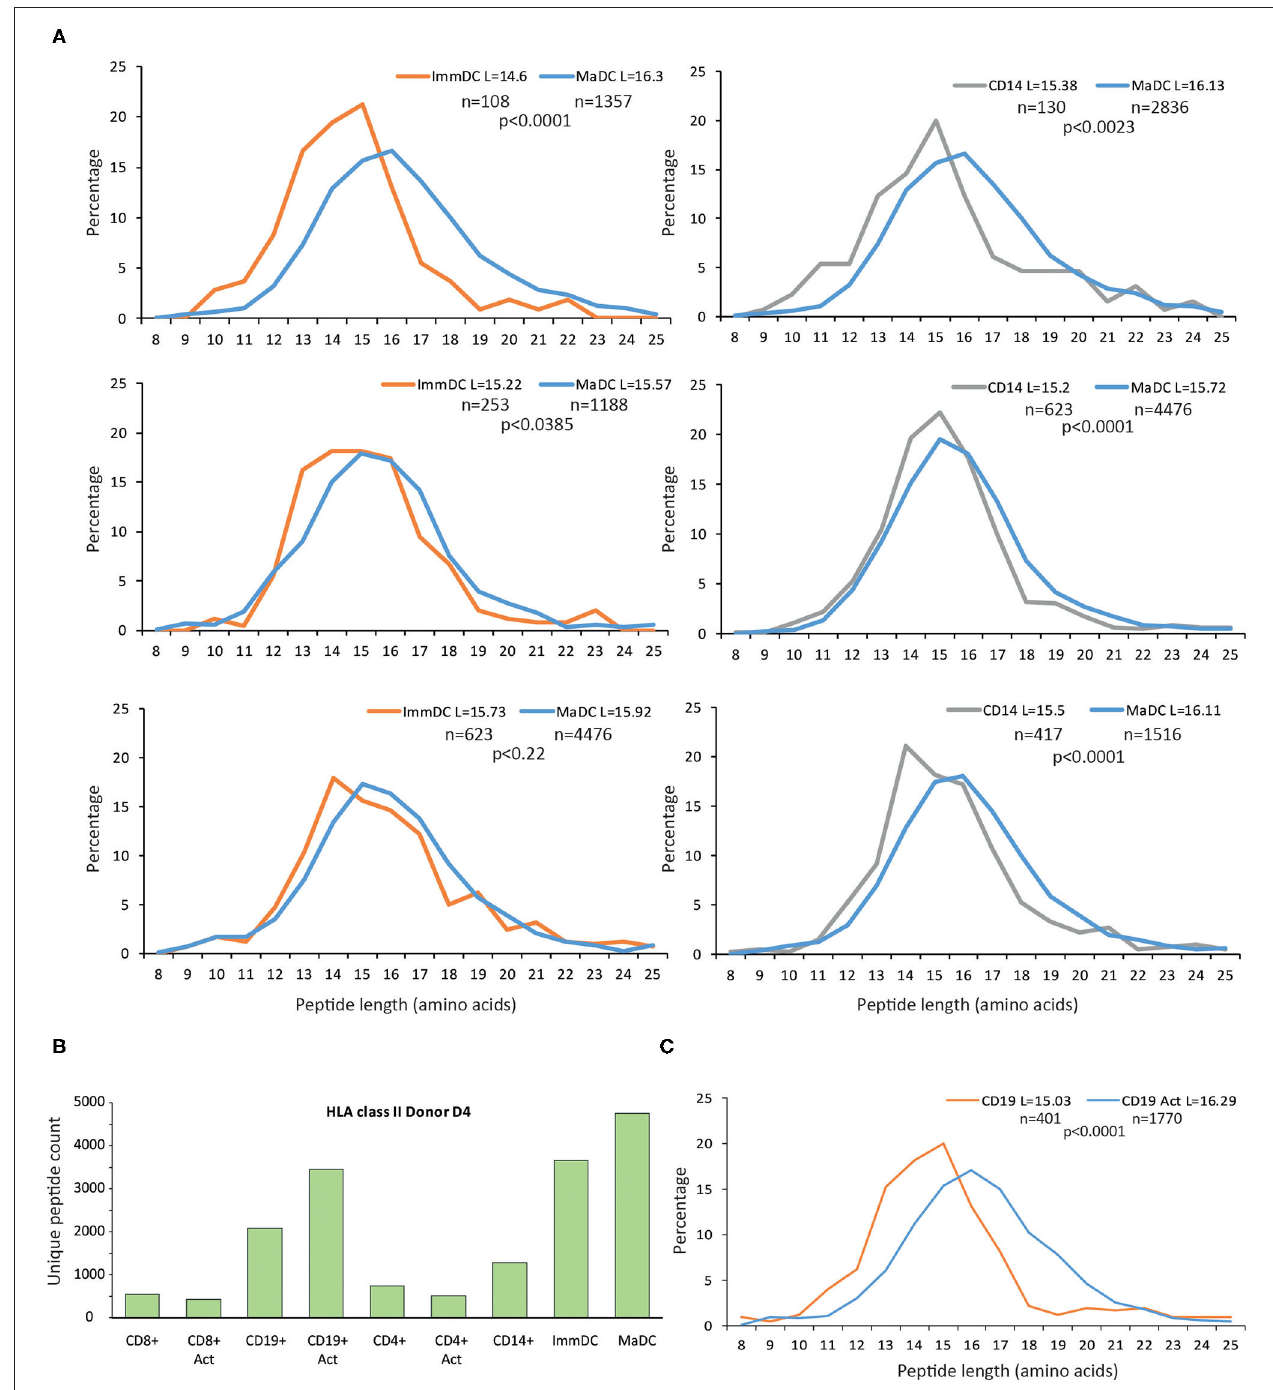
FIGURE 3 | Length distribution of HLA class II peptides upon differentiation and activation of immune cells. (A) Upon differentiation and activation of DCs, longer peptides are presented by HLA-II allotypes. For these comparisons only donors with at least 100 unique peptides were displayed. (B) Overview of unique HLA class II peptides identified in CD14 + , immature and mature DCs, CD8 + , CD4 + , CD19 + cells either activated, or unstimulated. (C) Length distributions of unique HLA-II peptides presented in CD19 + either unstimulated or activated with CD40L. Average length (L) for each cell type is reported together with the statistical significance (unpaired t -test, p